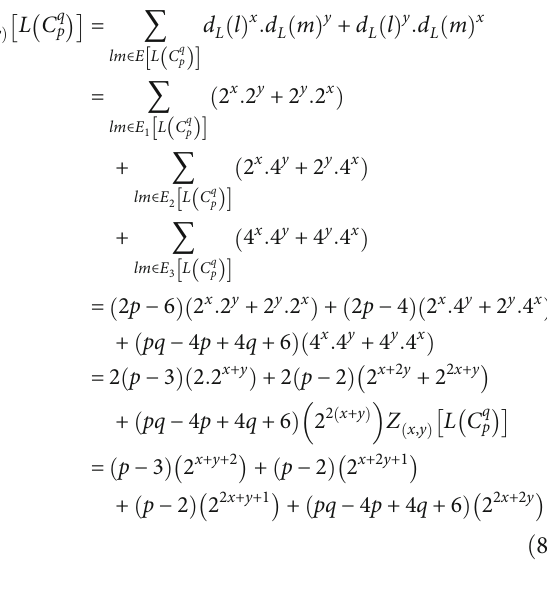
The expressions for di ff erent indices about line graph of para squares cactus chain L ð S q Þ can be obtained from Theo- rem 1 by taking p = 4 The representation of L ð S q Þ is shown in Figure